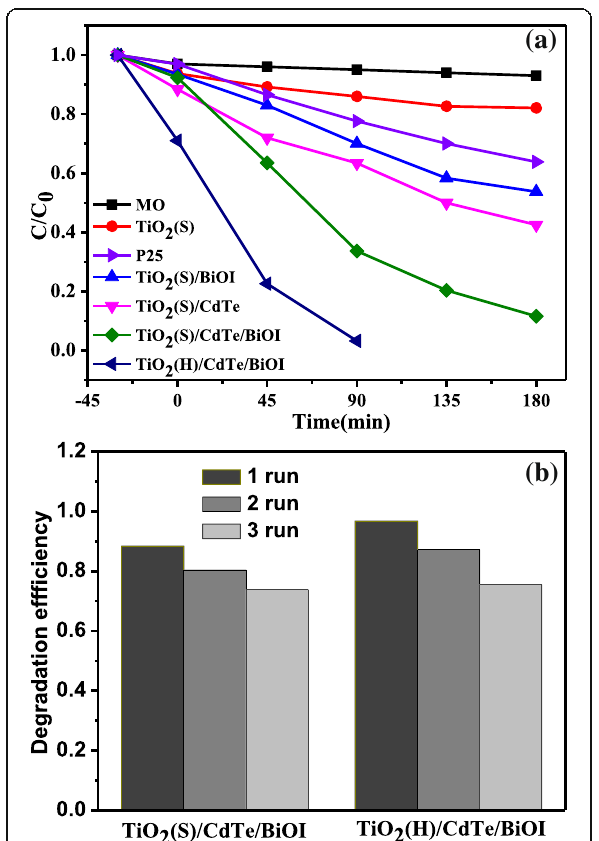
Fig. 7 a Photocatalytic performance of the samples for MO removal. b Photocatalytic recycle experiments for the TiO 2 (S)/CdTe/BiOI and TiO 2 (H)/CdTe/BiOI